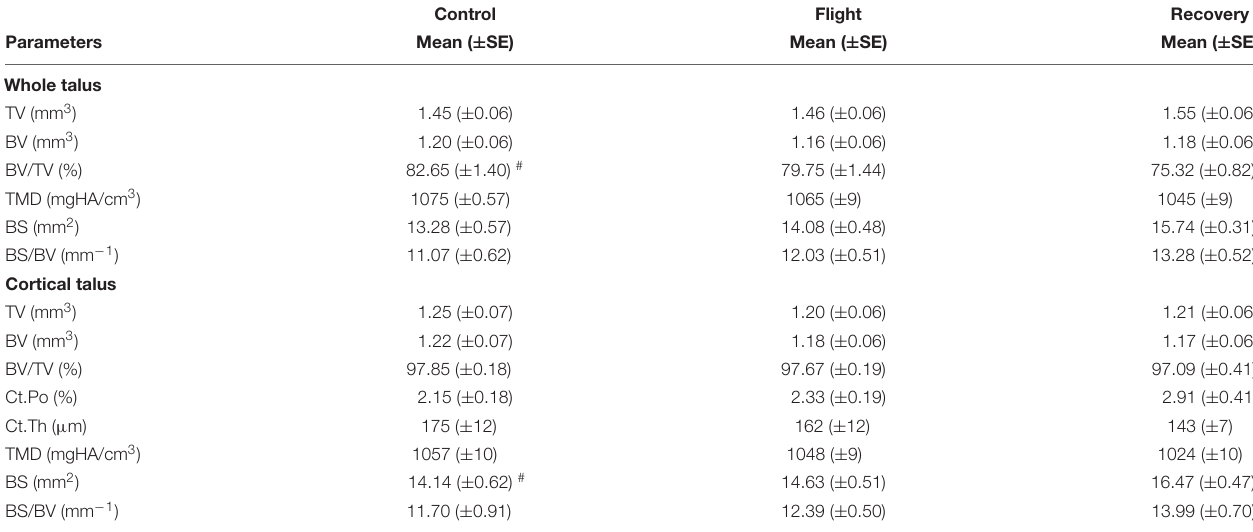
TABLE 5 | Effect of spaceflight, spacecraft housing, and recovery on talus microarchitecture